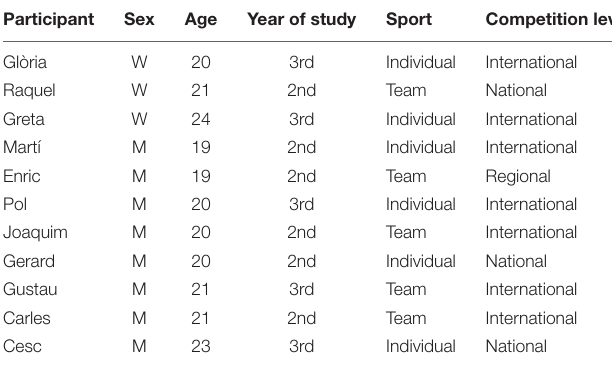
TABLE 1 | Characteristics of the